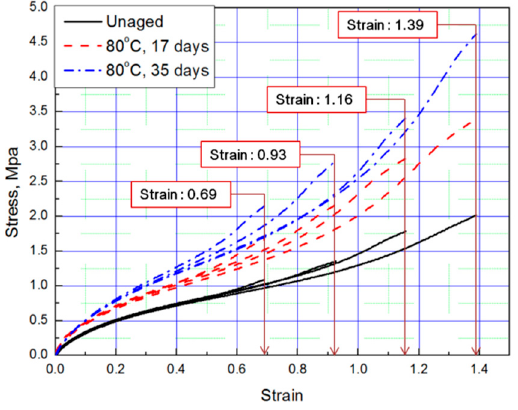
Figure 1. Tensile curves according to aging time (Strain: 0.69, 0.93, 1.16, 1.39).